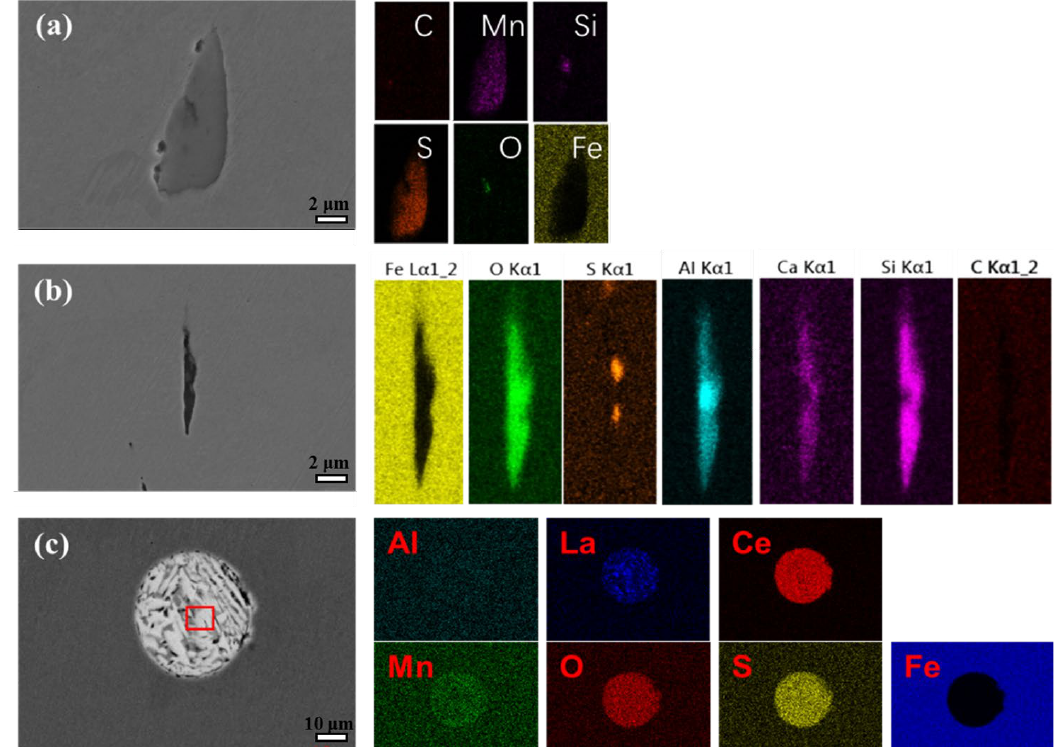
Figure 2. Observation and element distribution of inclusions in ( a ) BM, ( b ) Cr, and ( c ) RE steel rebars.